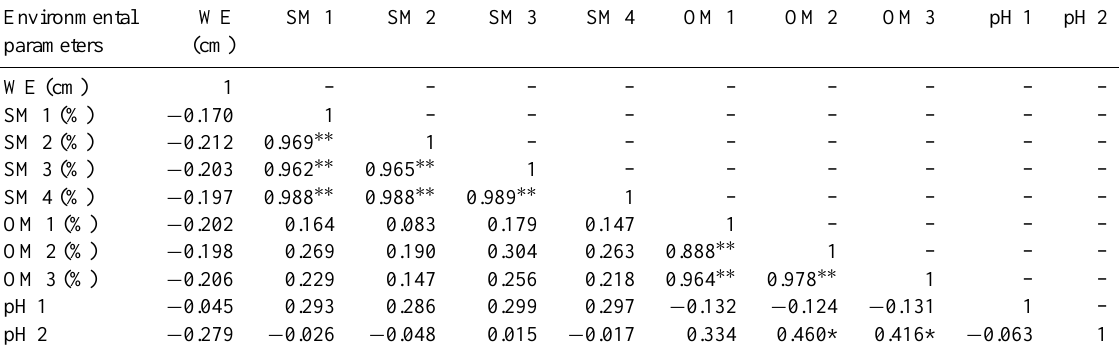
Table 3. Pearson correlation coefficients between environmental (i.e. intensity of wind erosion) and soil physicochemical variables (i.e. soil moisture and organic matter contents, and pH) at the study site. Correlations were either non-significant or significant at the 0.01 ( ∗∗ ) or 0.05 ( ∗ )